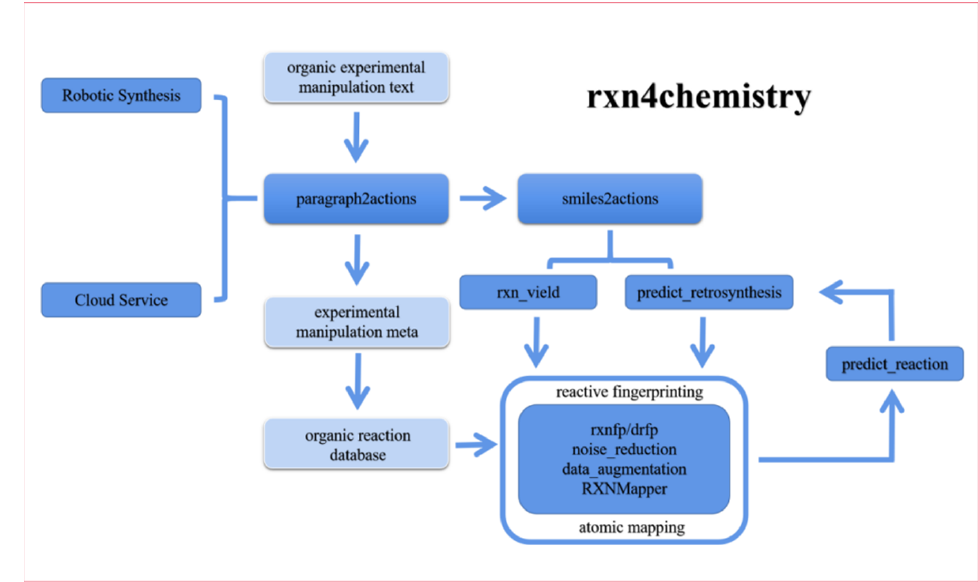
Figure 11. IBM RXN for Chemistry main work and its overall idea.